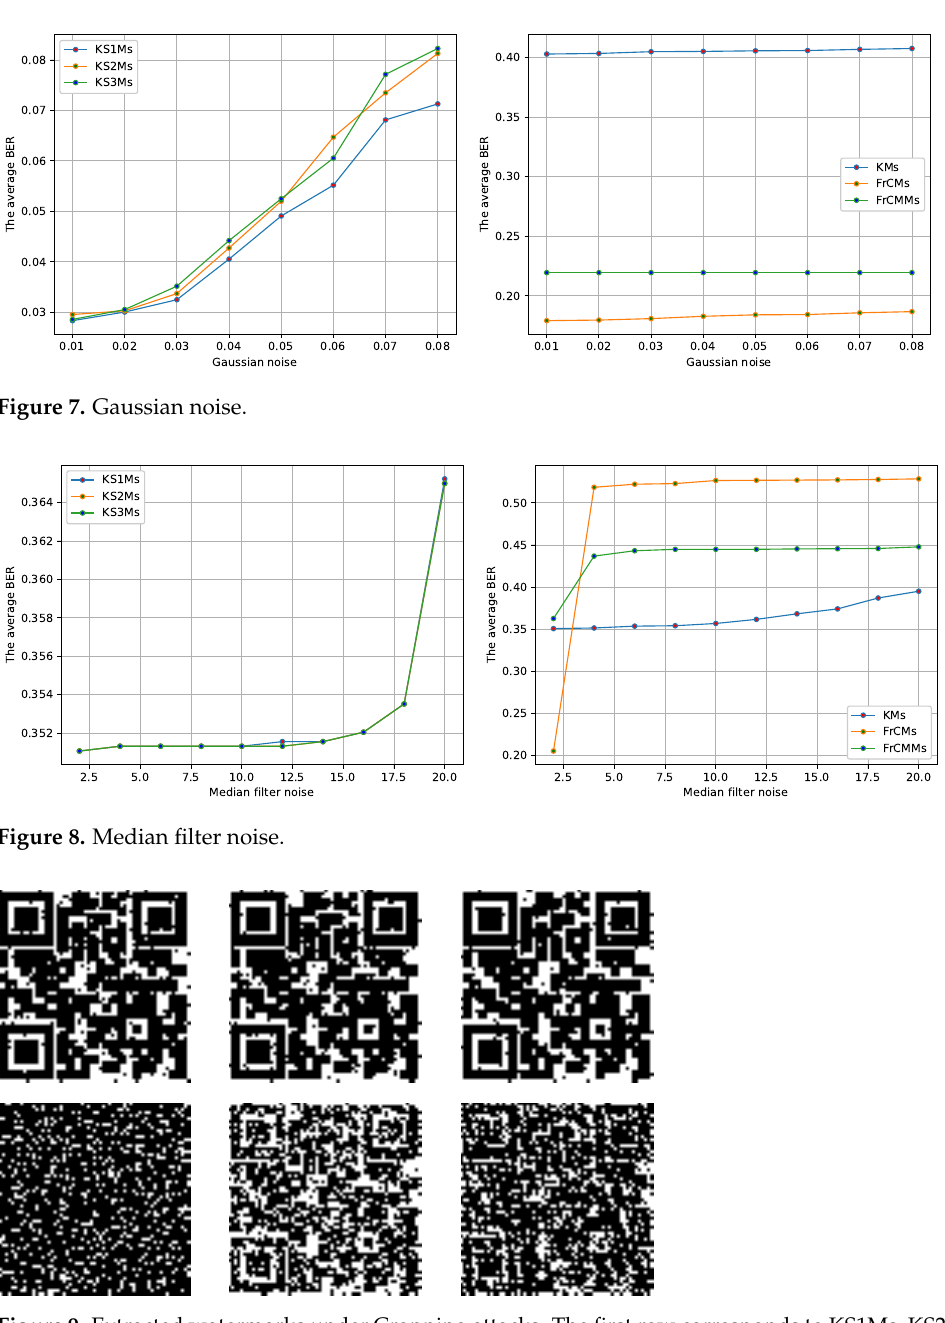
Figure 9. Extracted watermarks under Cropping attacks. The first row corresponds to KS1Ms, KS2Ms, and KS3Ms while the second row corresponds to KMs, FrCMs, and